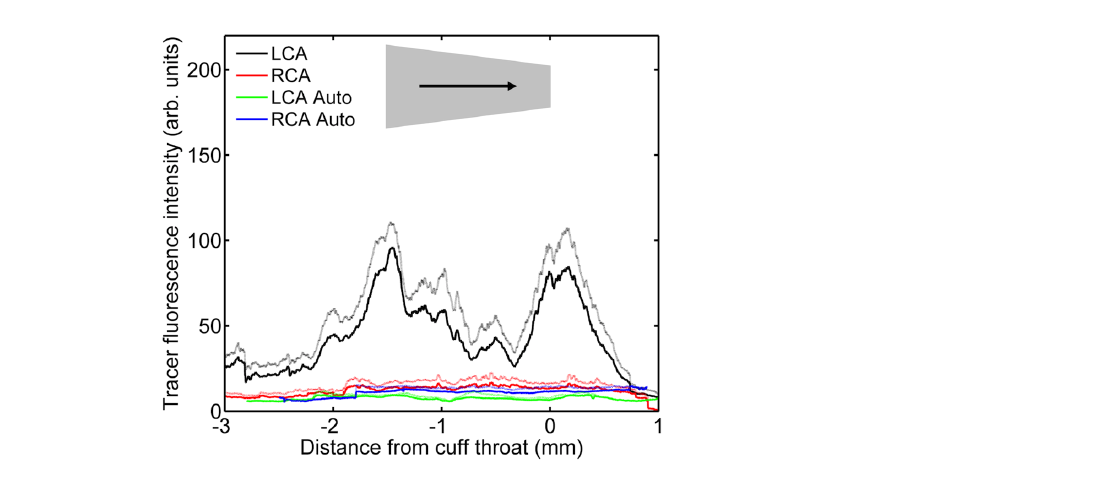
Fig. 13. Effect of L-NAME on tracer uptake along vessels with the cuff in the conventional orientation. Fluorescence intensity along the length of carotid arteries of L-NAME-treated mice having the cuff placed around their left carotid in the conventional direction. Intensity is shown separately for the cuffed left carotid (‘‘LCA’’) and uncuffed right carotid (‘‘RCA’’) of mice administered tracer or not administered tracer (indicating autofluorescence; ‘‘Auto’’). Flow direction, cuff location and cuff orientation are indicated as described for Fig. 2. Mean (dark lines) + 1 SEM (light lines), n 5 6 for mice given tracer and n 5 2 for autofluorescence.